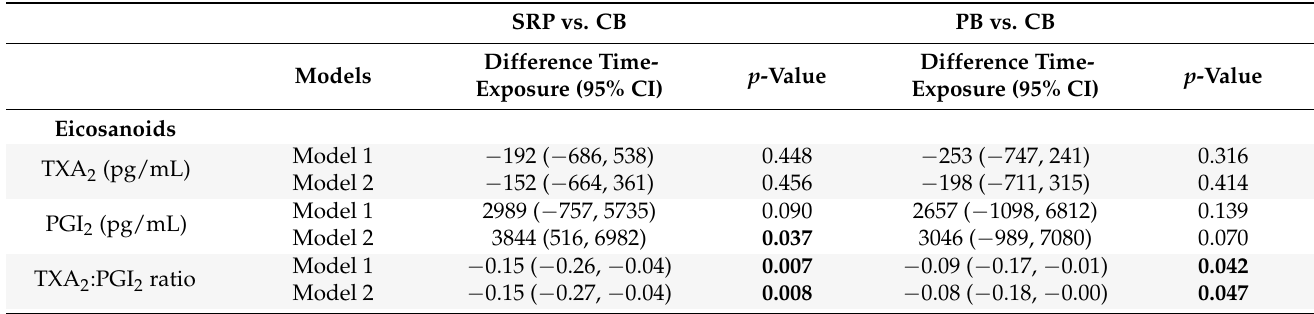
Table A2. Intervention effect on the levels of urinary eicosanoids at 6